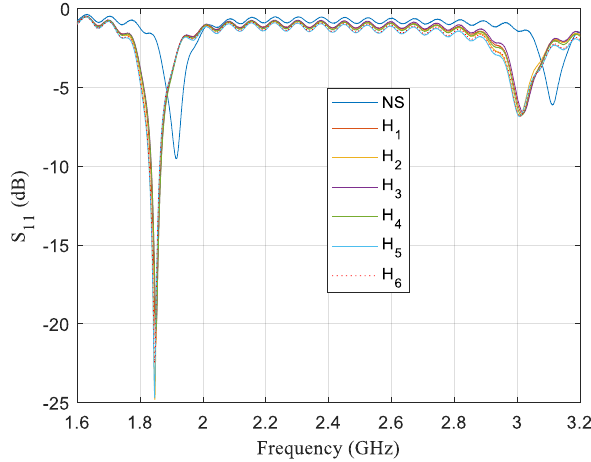
Figure 7. Frequency response of a sensor for a single test where the sensor is configurated in en- hancing the performance zone for the same six honey samples used for Figure 6. Two modes are displayed to show off the discrepancies. For the mode ~3.1 GHz, there is almost no change in the insertion loss values when honey samples are present or not. Nevertheless, for the mode of around sample and when a sample is placed on the sensor is consistent with the difference in relative per- mittivity of air and honey.